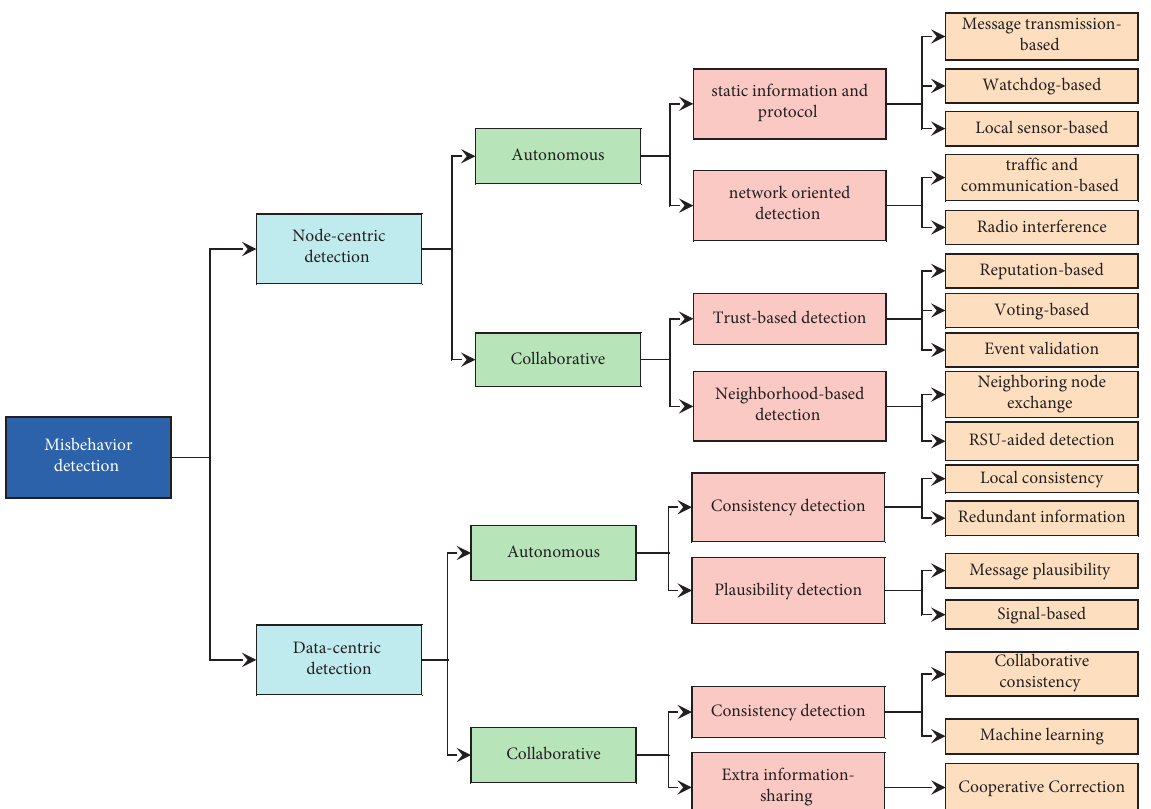
Figure 4: The taxonomy of misbehavior